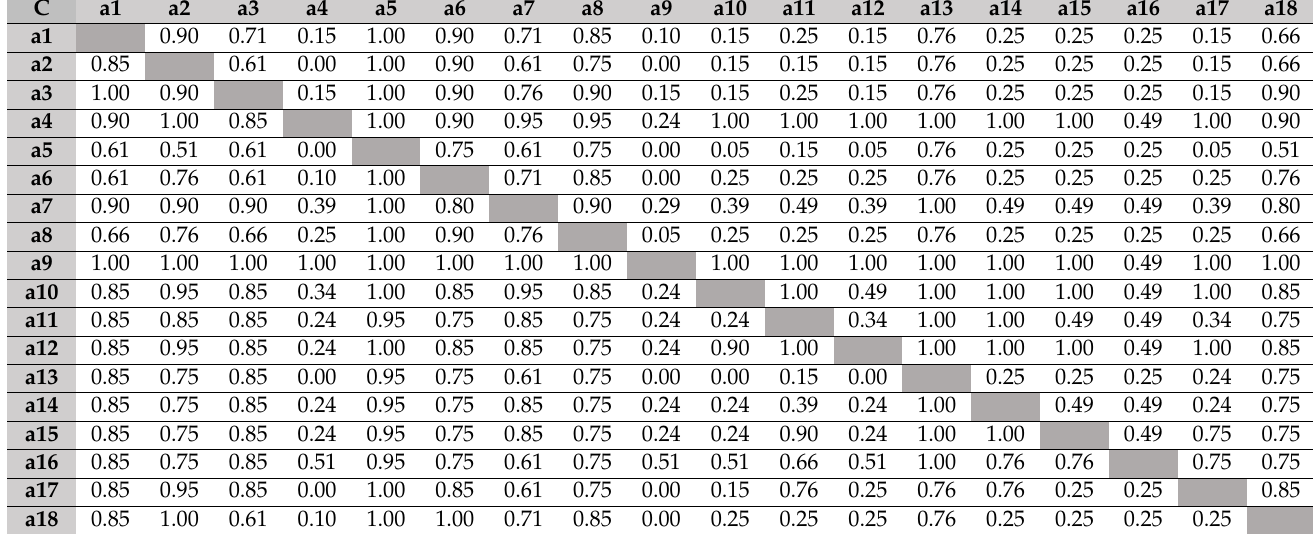
Table 13. Concordance matrix generated by pairwise comparison of all alternatives.